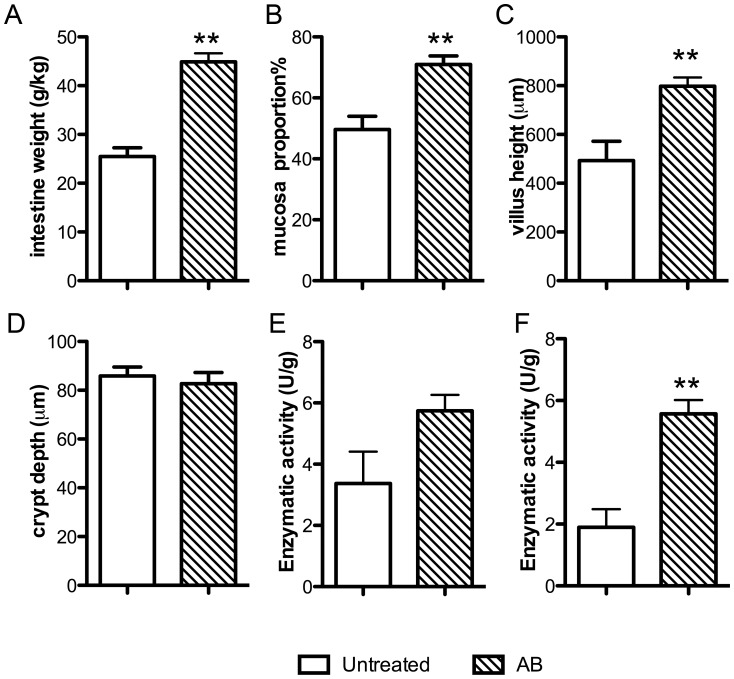
Small intestine weight, mucosa weight, villus height, crypt depth and enzymatic activities of ApN and ApA. Data are presented as mean±SEM.** p<0.01 in AB vs untreated pigs.